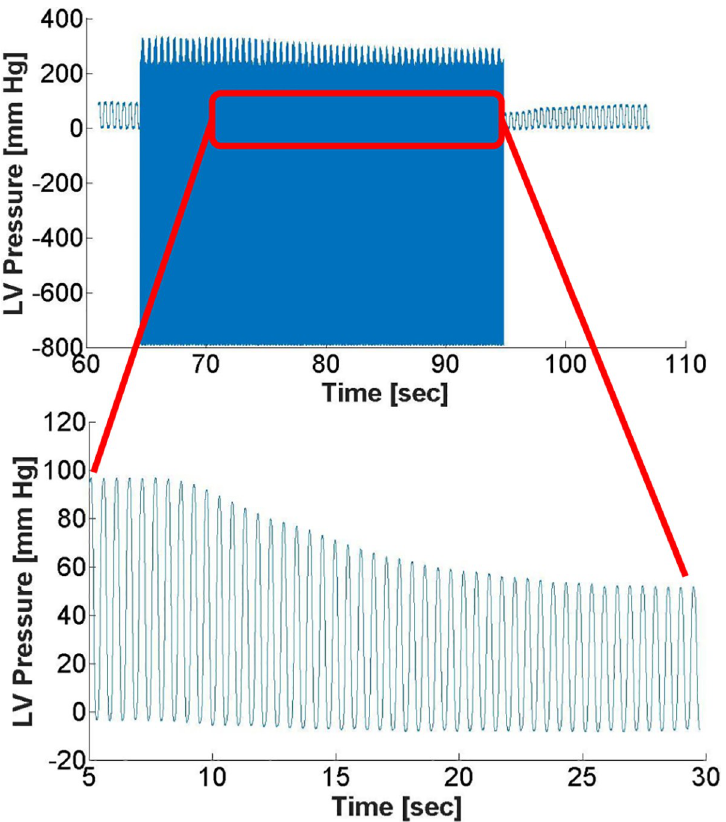
Fig 2. Raw pressure data with noise prior to digital filtering and calibration (top) with the insert showing filtered and calibrated LV pressure during the selected VCO range.